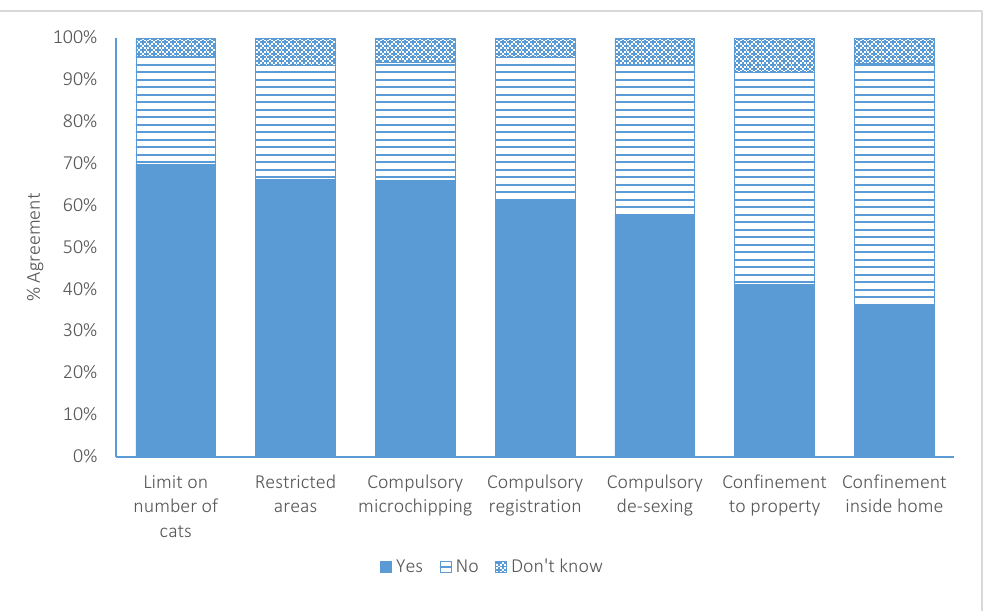
Figure 2. Participant agreement to seven posited restrictions regarding companion cat ownership in New Zealand.